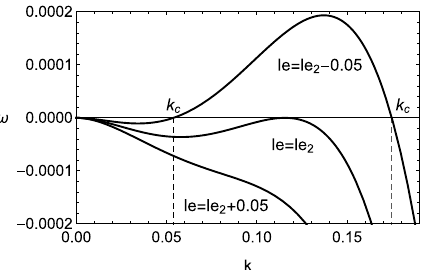
0 . In this 0.1 and Pr 10 , q = = =